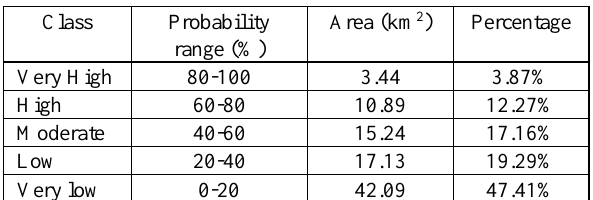
Table 3. The landslide probability distribution in the study